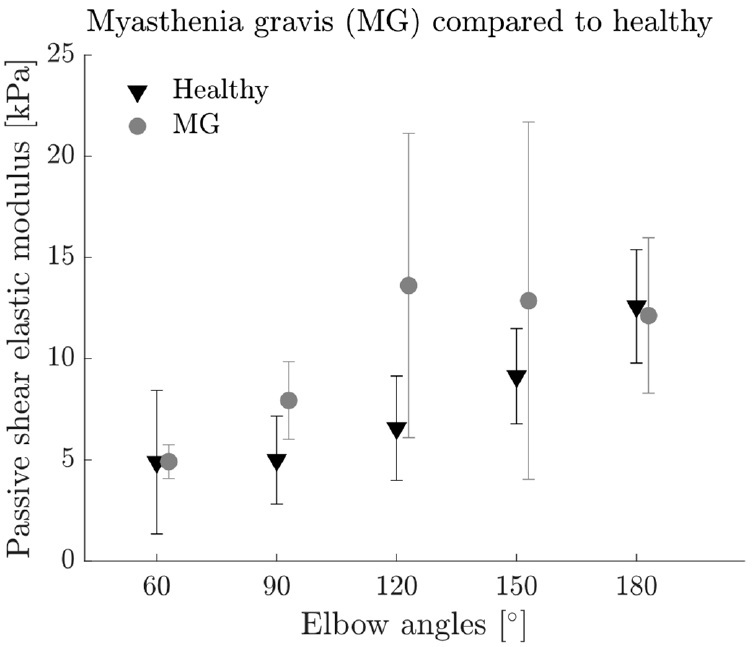
Figure 5. Average passive shear elastic modulus of the biceps brachii muscle of myasthenia gravis (MG) patients (grey circles) compared to healthy population (black triangles) reported previously [13] at passive state for the five elbow angles studied (60 ◦ , 90 ◦ , 120 ◦ , 150 ◦ and 180 ◦ ). Error bars visualize the standard deviation. Two-way ANOVA revealed significant differences between the groups ( p = 0.002) and elbow angles ( p < 0.001).